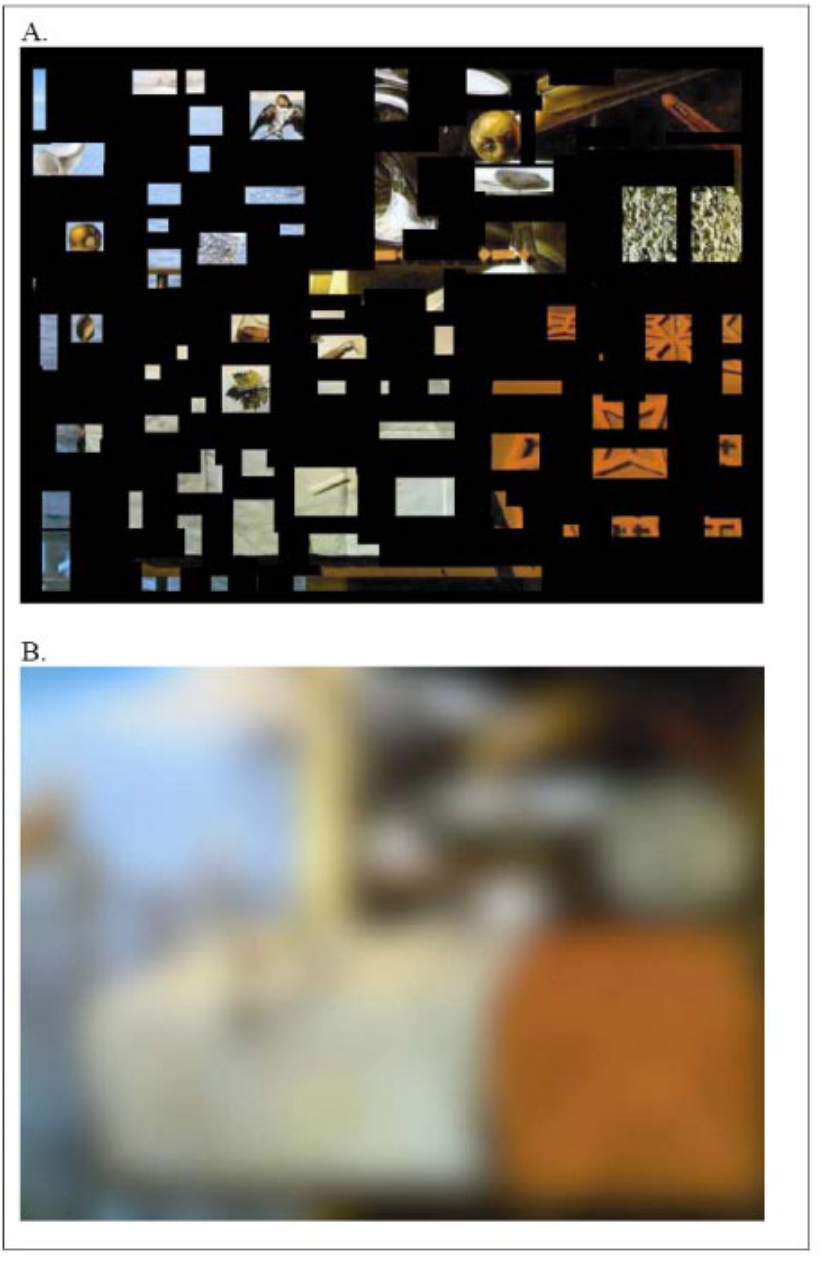
Fig. 1 . (A) Excellent disciplinary work can lead to precise pictures of parts of the whole. (B) A generalist perspective can encompass the whole, but precision may be low and uncertainty may increase